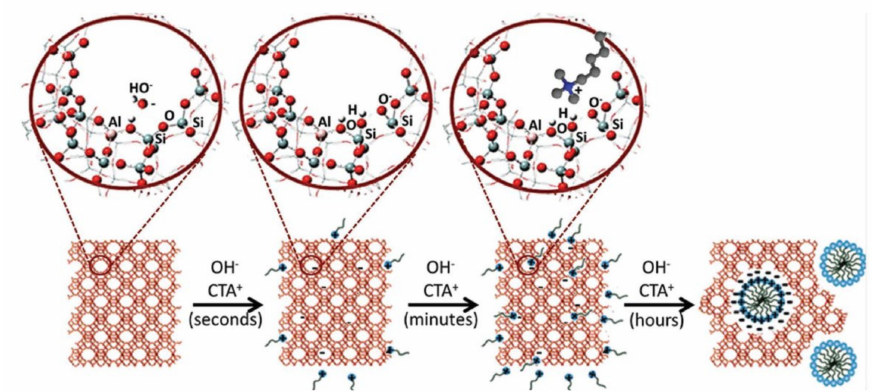
Figure 10. Schematic representation of the different steps involved in the surfactant-templating of zeolites: (i) the hydroxyl groups react with the zeolite network to generate negatively charged sites (Si–O–Si + OH − > SiO − +Si–OH); (ii) the cationic surfactant molecules are attracted inside the zeolite by electrostatic interaction; and (iii) the surfactant molecules self-assemble in micelles inside the zeolite crystals, forming the mesoporosity. Adapted with permission from Reference [97]. Copyright (2020) Wiley-VCH